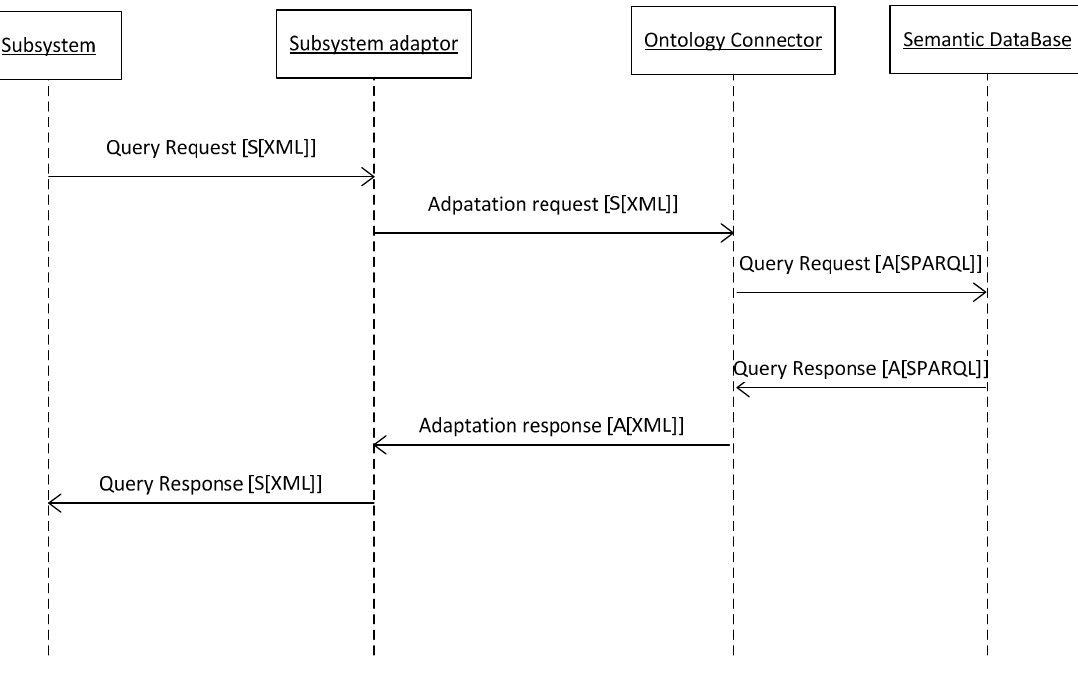
Figure 4. Discovery process in ACCUS.